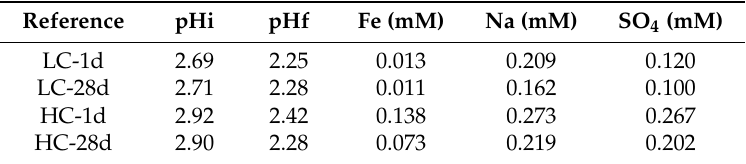
Table 1. Concentration of Fe, Na, sulphate and pH at the beginning (pHi) and at the end (pHf) of each reaction